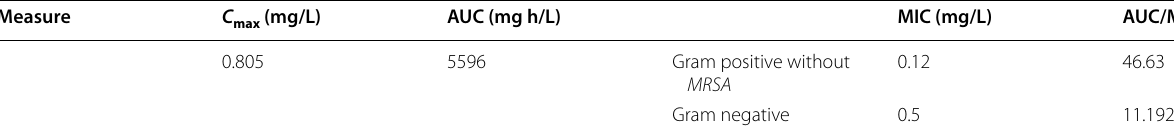
AUC: area under the concentration–time curve over 12 h; MIC: minimum inhibitory concentration